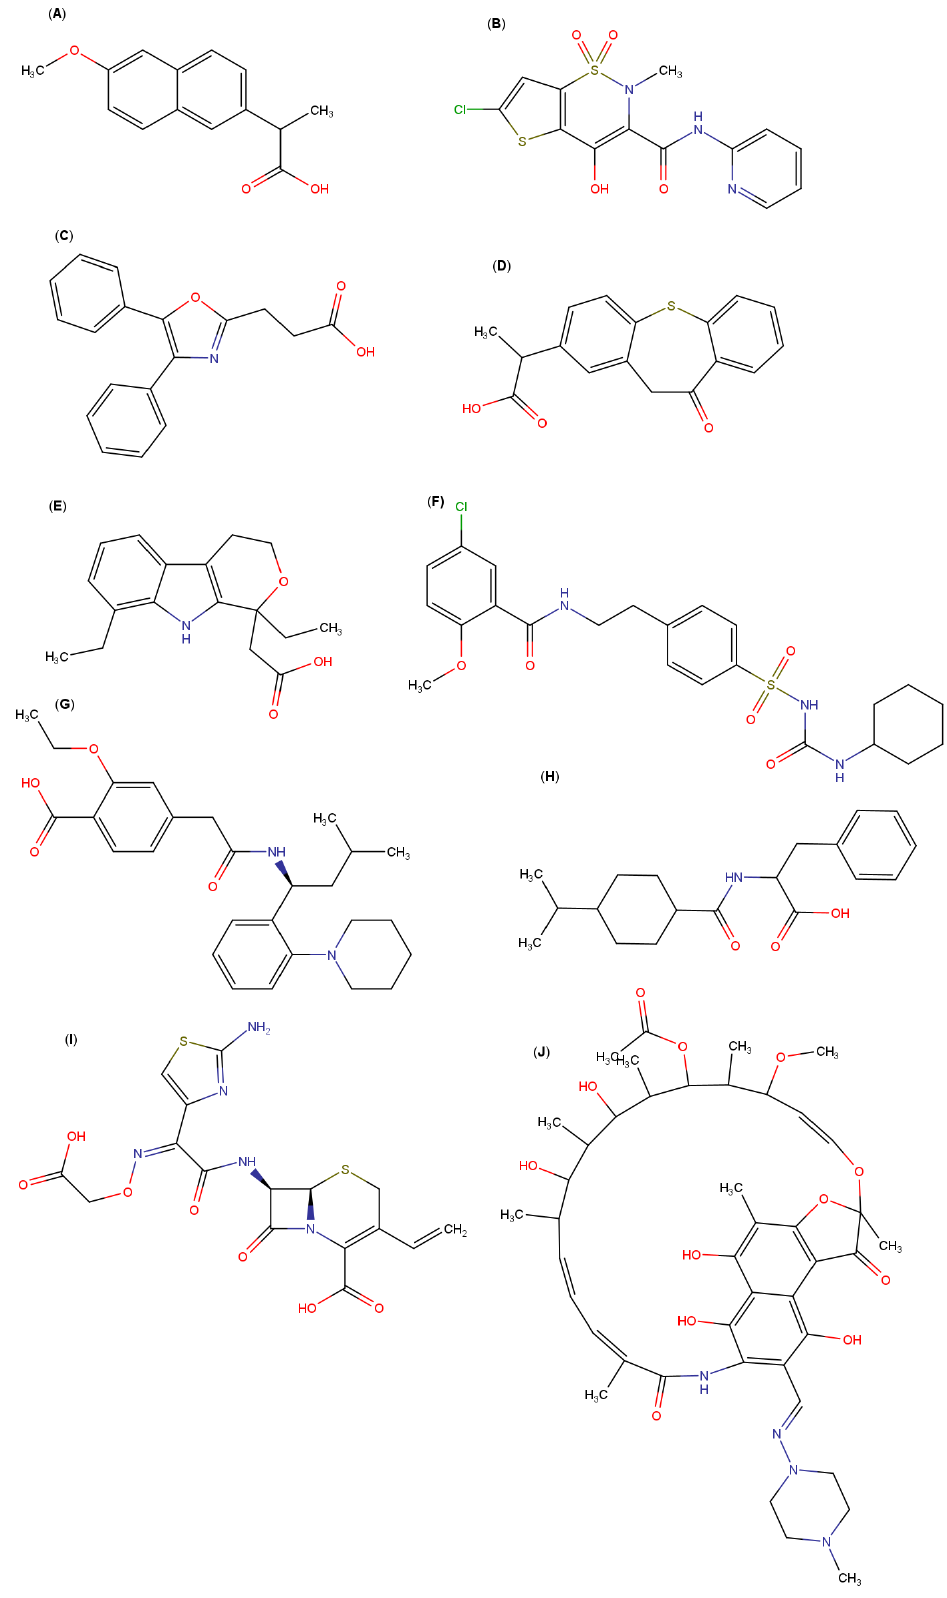
Figure 3. Molecular structures of: ( A ) naproxen, ( B ) lornoxicam, ( C ) oxaprozin, ( D ) zaltoprofen, ( E ) etodolac, ( F ) glyburide, ( G ) repaglinide, ( H ) nateglinide, ( I ) cefixime and ( J ) rifampicin.